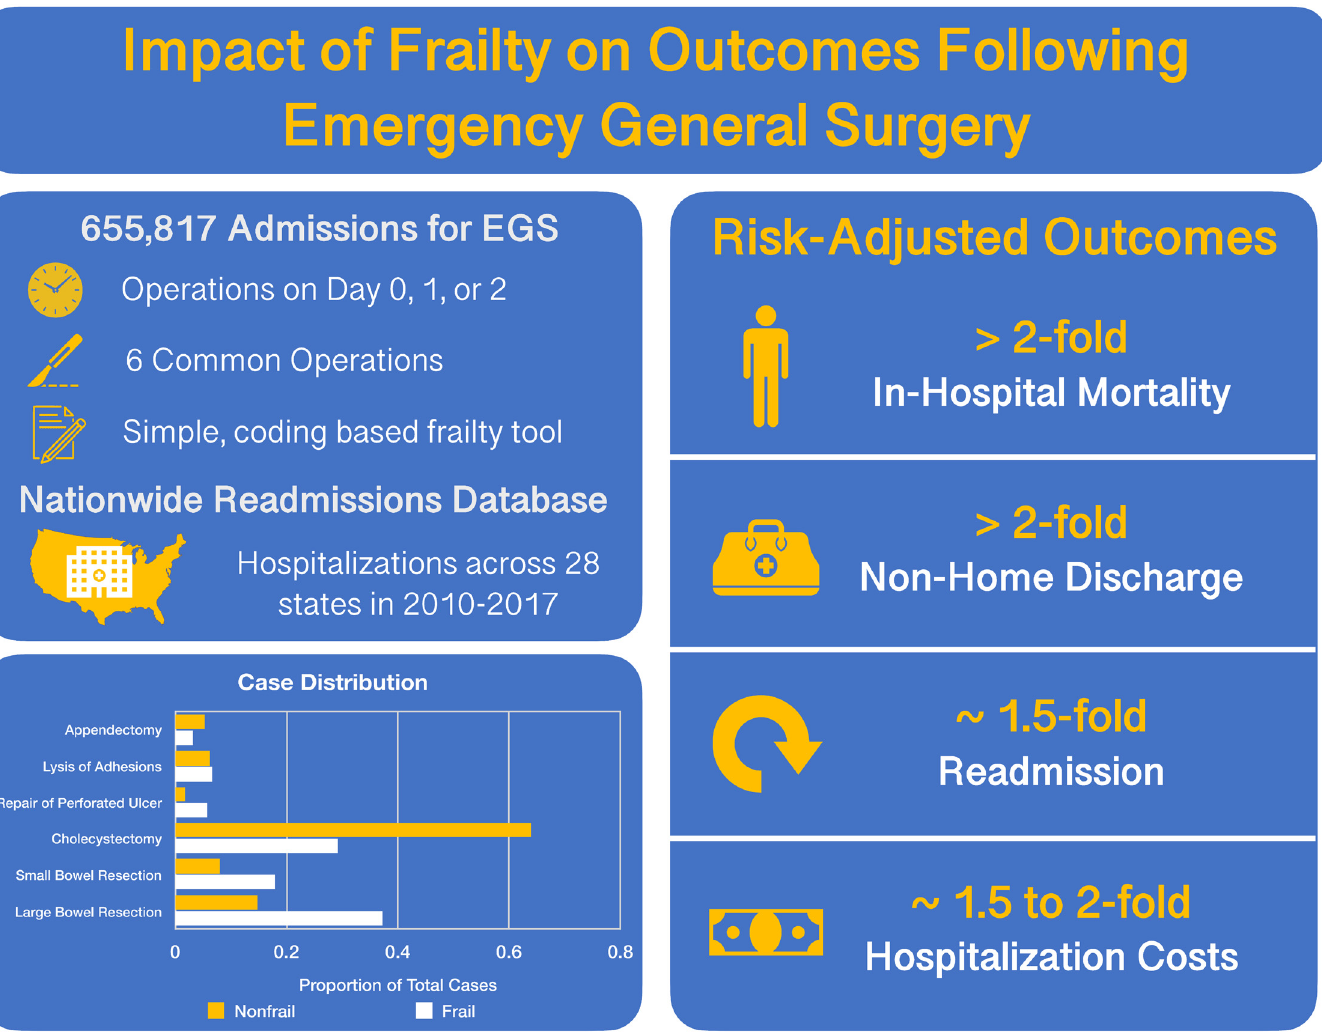
Fig 3. Visual summary of study findings. Frailty adversely impacts odds of in-hospital mortality, non-home discharge, readmission, and is associated with greater resource